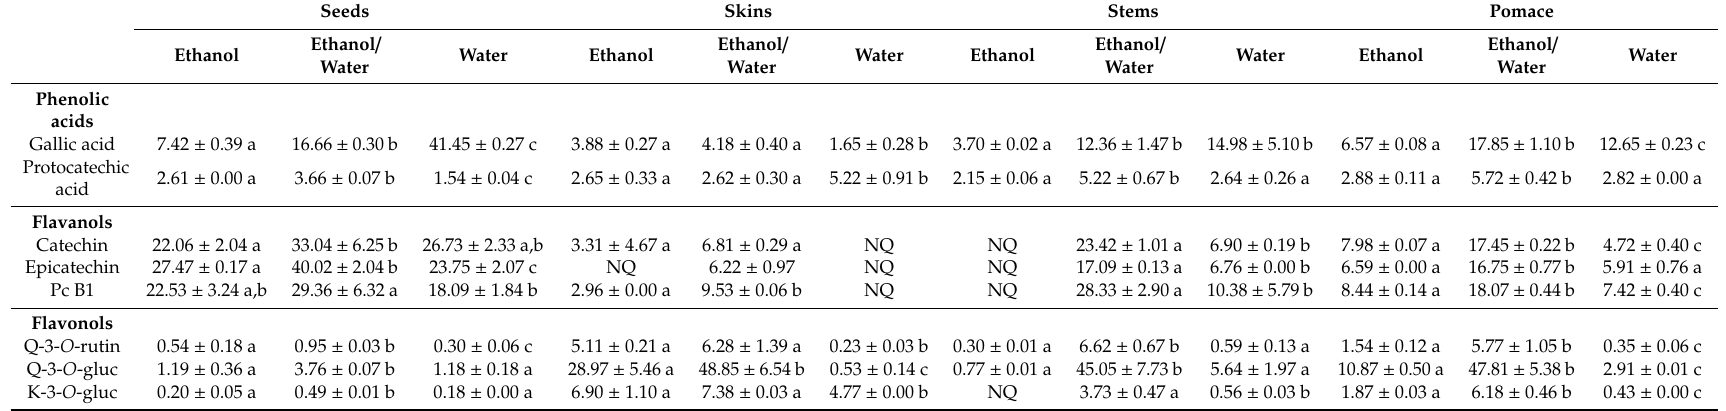
Table 1. Phenolic compounds identified and quantified (mg / 100 g) in seeds, skins, stems and pomace extracts obtained with di ff erent solvents (ethanol, ethanol / water and water). Seeds Skins Stems Pomace Water Ethanol Water Ethanol